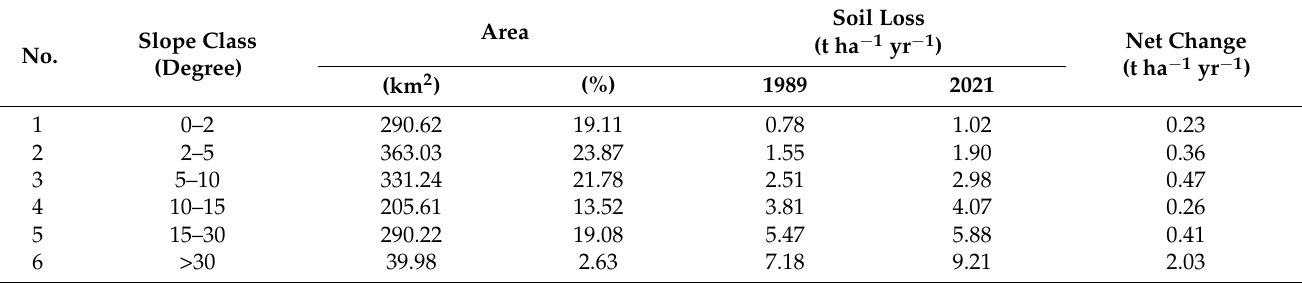
Table 12. Soil loss rates in slope classes and net changes between 1989 and